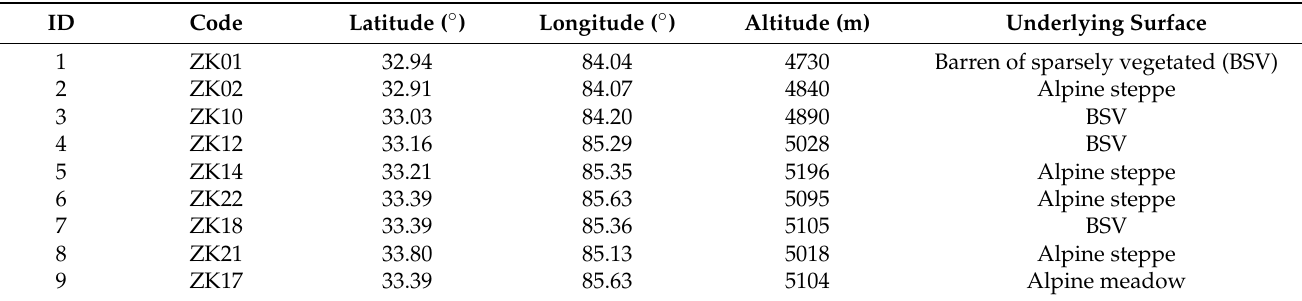
Table 1. Details of nine representative boreholes in the Gaize